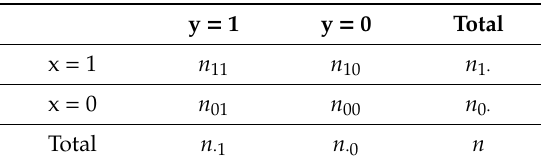
Table 1. Contingency